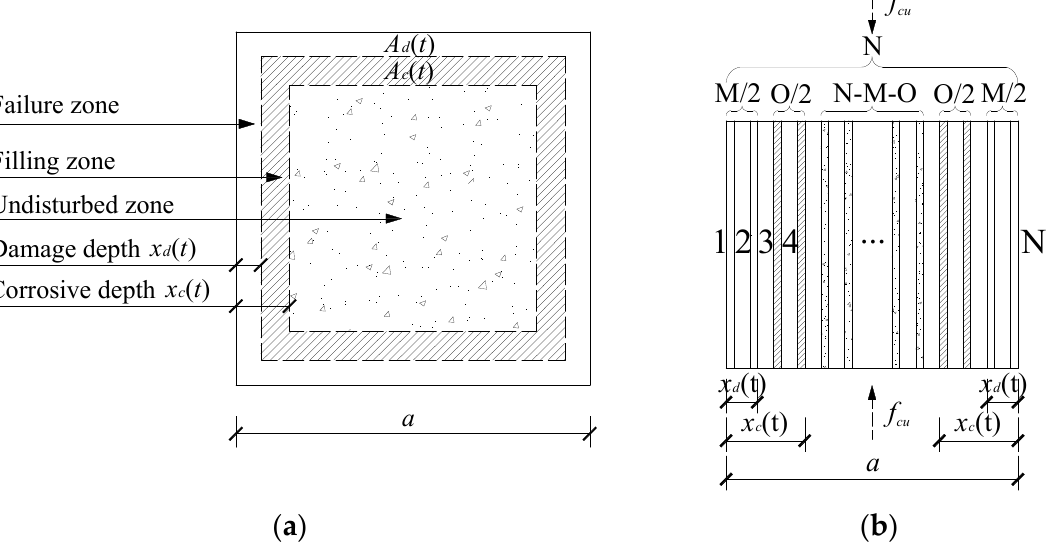
Figure 7. Mechanical model of compressive strength considering the corrosion effects. ( a ) Corrosion effects, ( b ) Parallel bar system.